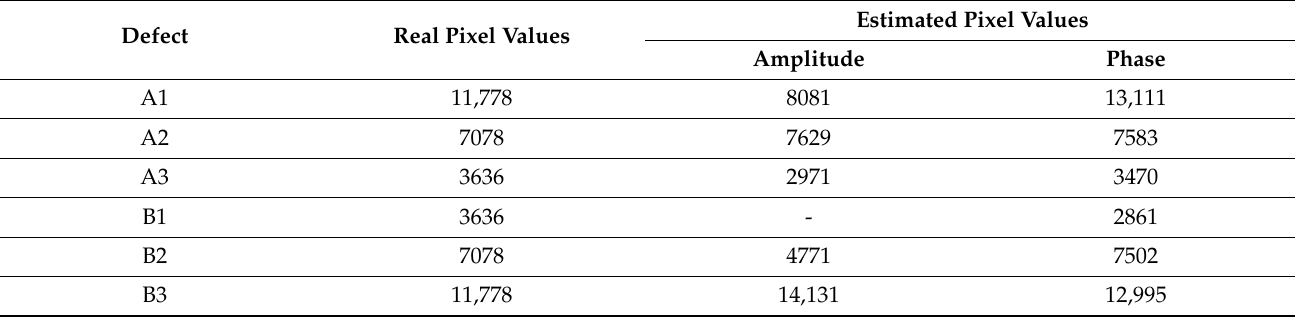
Table 2. RMSE values for phase and amplitude images.